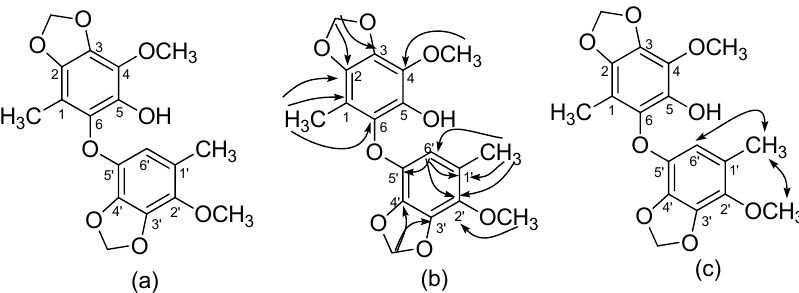
Figure 4. Structure of benzocamphorin I ( 4 ) ( a ) and its key HMBC ( b ) and NOESY ( c ) correlations.